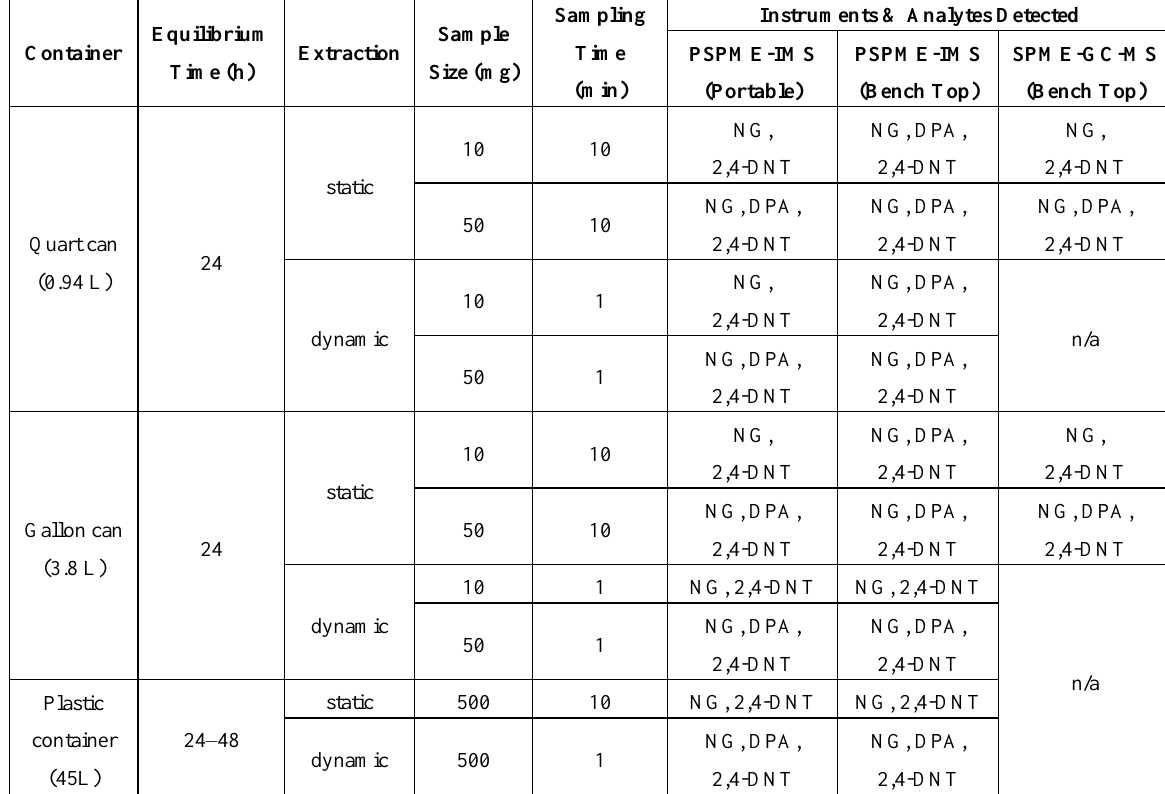
Table 3. Detection of analytes of interest (NG and DPA from All Unique